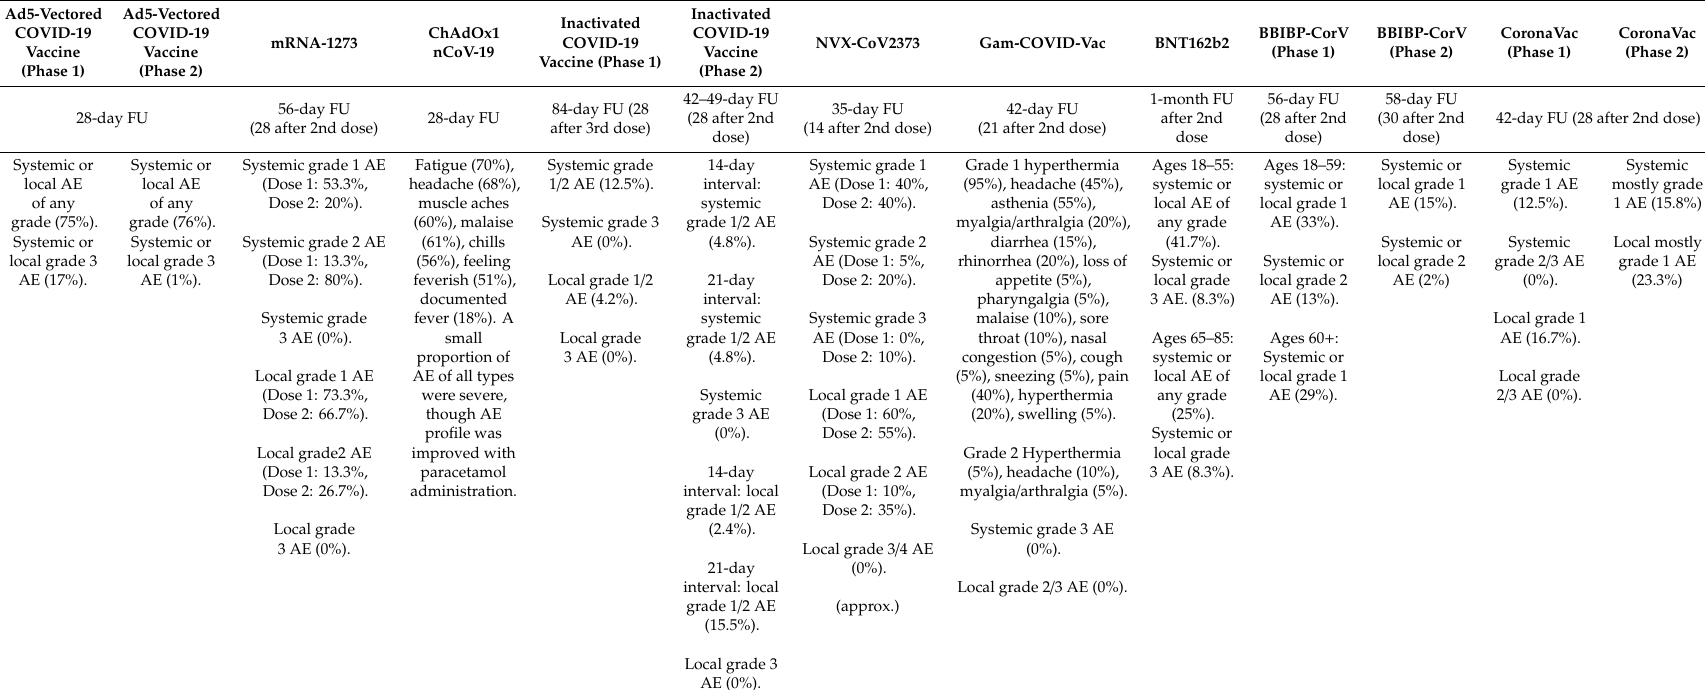
Table 2. Safety outcomes of COVID-19 vaccine phase 1 or 2 clinical